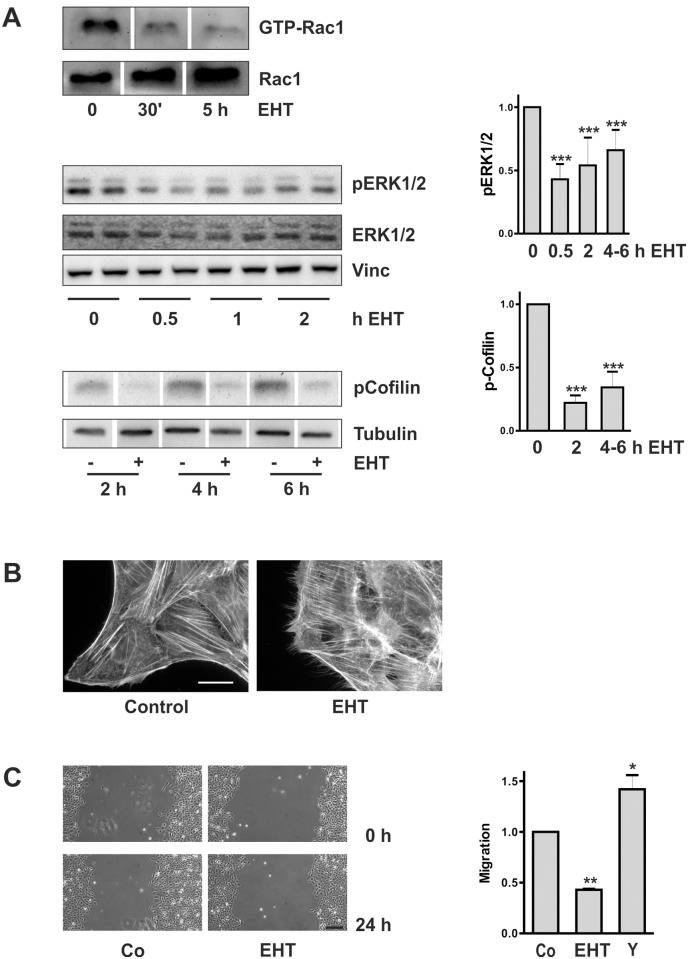
Cellular effects of Rac1 inhibition by EHT1864.(A) HKC-8 cells were incubated with EHT1864 (10 μM) for the times indicated. Rac1 activity was determined by pull down experiments. The blot is representative of 3 experiments with comparable results. Samples were run on one blot which had to be rearranged. pERK1/2, ERK1/2 and vinculin were detected by immunoblot procedure. The blot shows duplicate biological samples. The graph summarizes data of n = 3–6 experiments (pERK1/2 / ERK1/2 or pERK1/2 / vinculin), means ± SD, *** p<0.001, compared to control cells, ANOVA with Dunnett’s multiple comparison test. pCofilin and tubulin were detected on one blot which had to be rearranged. The graph summarizes data of n = 4 experiments (pCofilin/Tubulin), means ± SD, *** p<0.001, compared to control cells, ANOVA with Dunnett’s multiple comparison test. (B) HKC-8 cells were treated with EHT1864 (10 μM) for 30 min. F-actin was visualized with PromoFluor phalloidin. Scale bar: 20 μm. (C) HKC-8 cells were seeded around barriers. After removal of the barriers (t = 0 h) the cells were treated with EHT1864 (10 μM) for 24 h. Scale bar: 200 μm. The graph summarizes the relative migration velocity of cells treated with 5 or 10 μM EHT1864 or 10 μM Y27632. Data are means ± SEM of 3 experiments with 4 determinations each. ** p< 0.01, * p<0.05 compared to control cells.